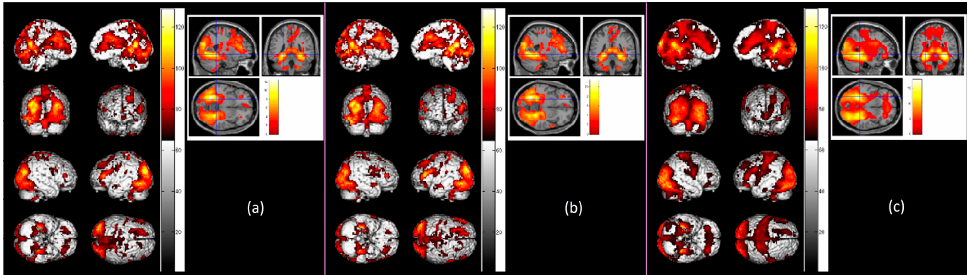
Figure 5. Significant cluster-level activations for novelty processing of scenes (N > R contrast), at p < 0.05 ( FDR -corrected) with k ≥ 20, after adjusting for gray matter probability, signal-to-fluctuation-noise (SFNR), and accuracy (ACC) performance. In the figure, from the left panel: ( a ) Significant activation among older adults ( n = 33) for novelty processing of scenes (N > R contrast); ( b ) Significant activation among older high performers ( n = 24) for novelty processing of scenes (N > R contrast); ( c ) Significant activation among young adults ( n = 48) for novelty processing of scenes (N > R contrast). BA, Brodmann Area. Table 1. Signi fi cant cluster-level activations for novelty encoding of scenes (N > R contrast), at p < 0.05 ( FDR -corrected) with k ≥ 20.